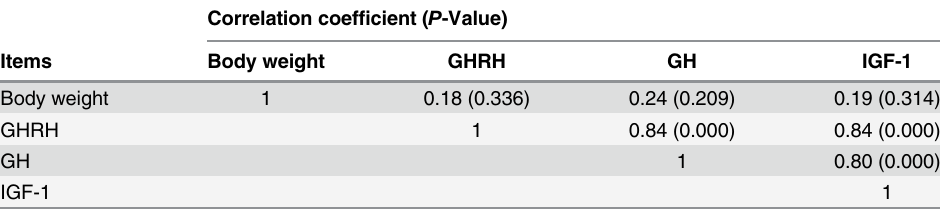
Table 3. Relationship between body weight and somatotropic axis hormone level (n =